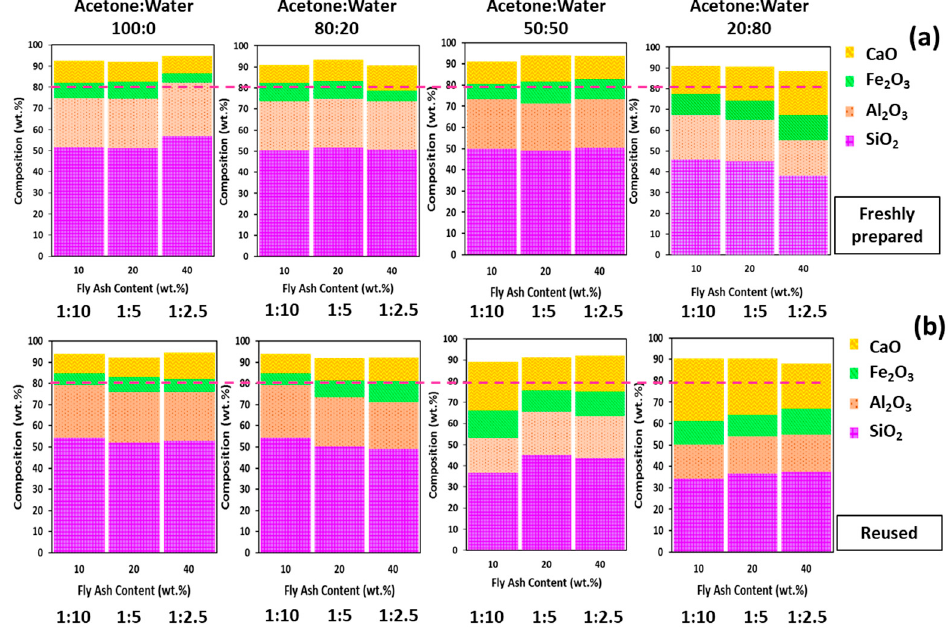
Figure 4. Stacked column plots of chemical compositions of cenospheres collected from using di ff erent acetone / water ratios, a 4-h soaking period, and fly ash / medium ratios of 1:2.5, 1:5, and 1:10. Data of ( a ) the freshly prepared and ( b ) the reused mixtures are presented for comparison.